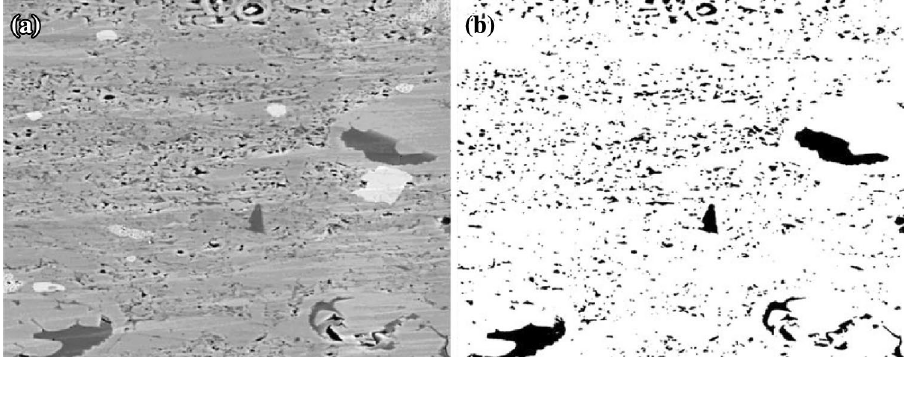
Fig. 2 Structure of nanopores in organic material of shale forma- tion. Reproduced with permis- sion from (Zeng et al.